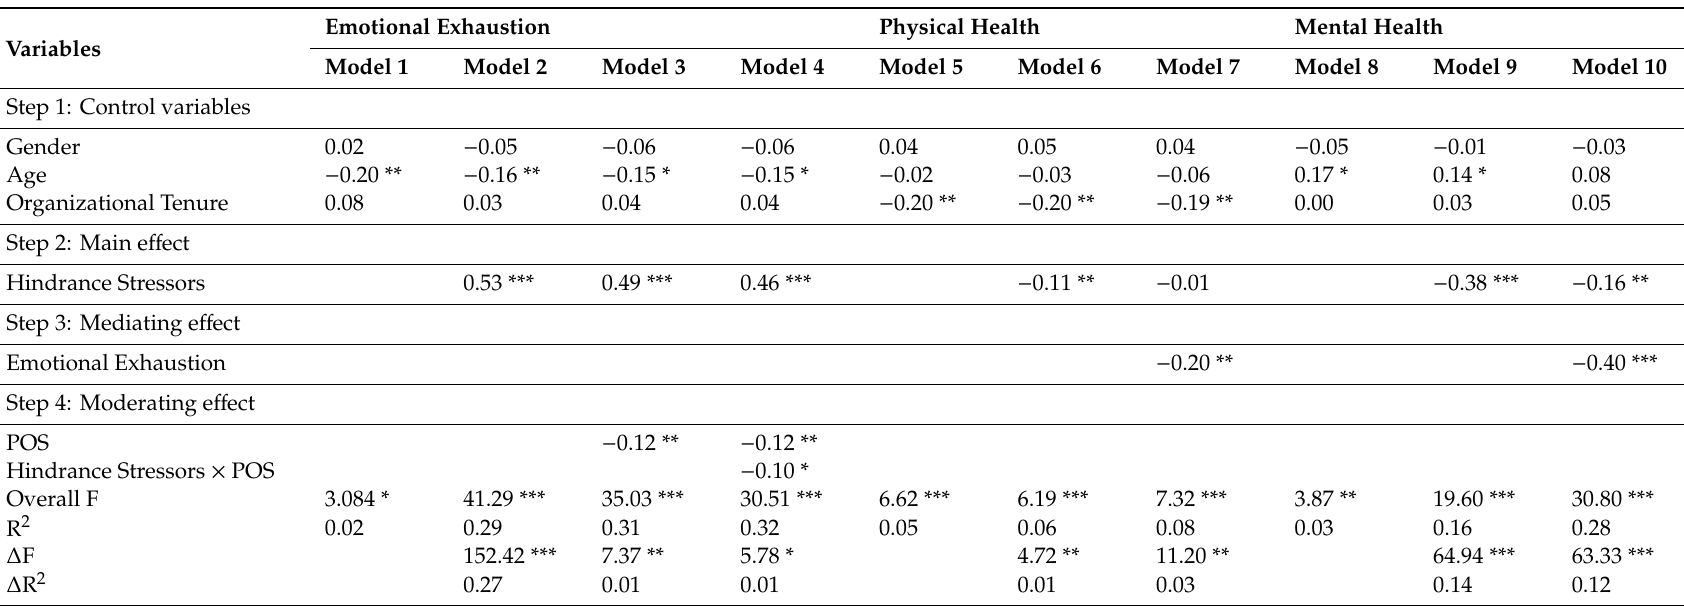
Table 3. Regression results for mediation and